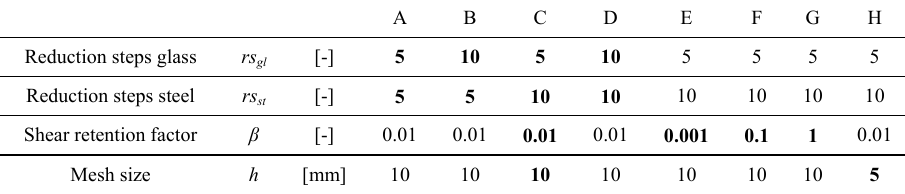
Table 2: Overview of the computational models with varying reduction steps and shear retention factors. A B C D E F